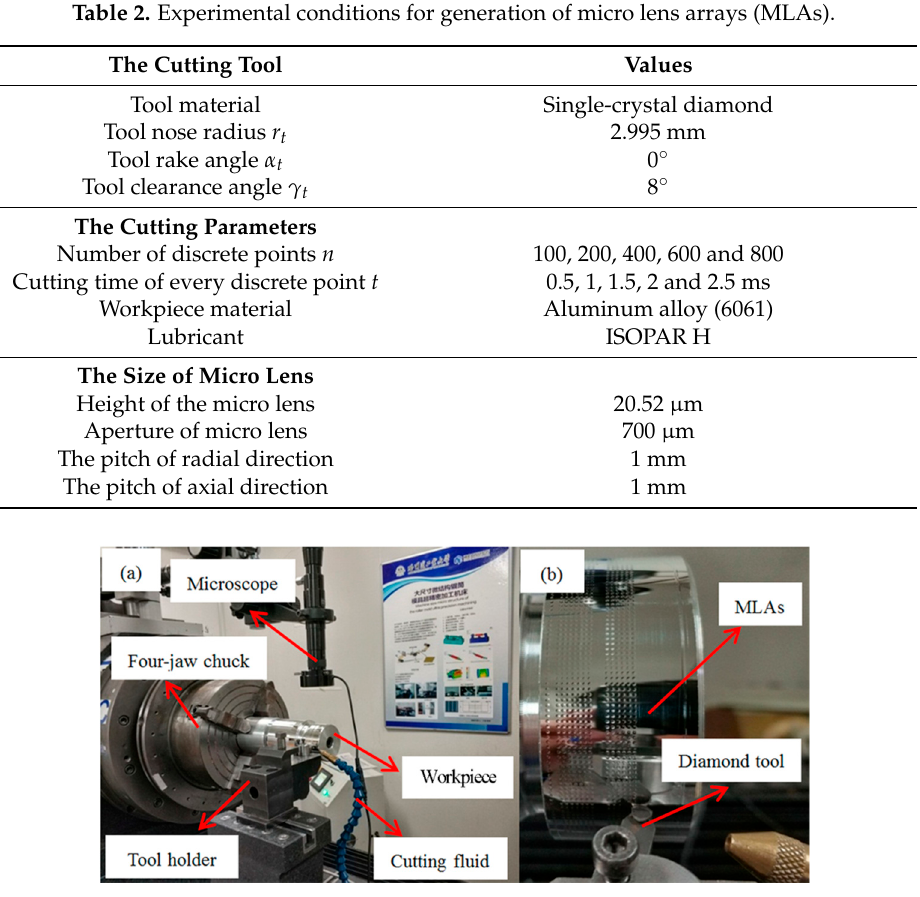
Figure 7. MLAs on the small workpiece. ( a ) The machining system; ( b ) partial enlarged